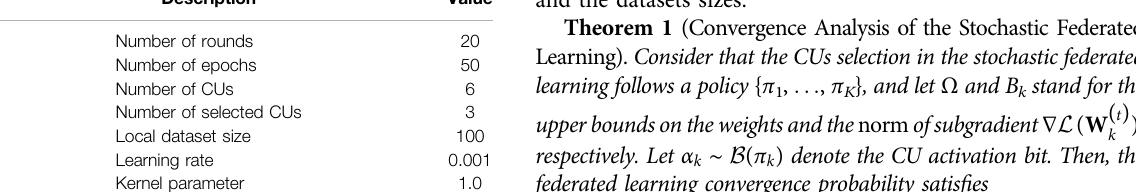
TABLE 2 | FL settings.